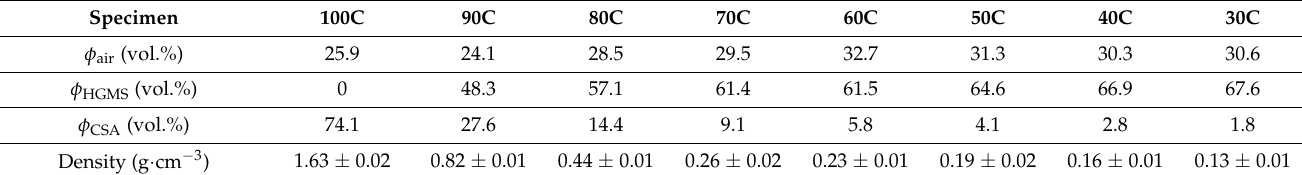
Table 3. Calculated volume fractions, ϕ i , of CSA cement, HGMSs, and air as well as the calculated density of the hydrated and dried specimens according to open porosity.